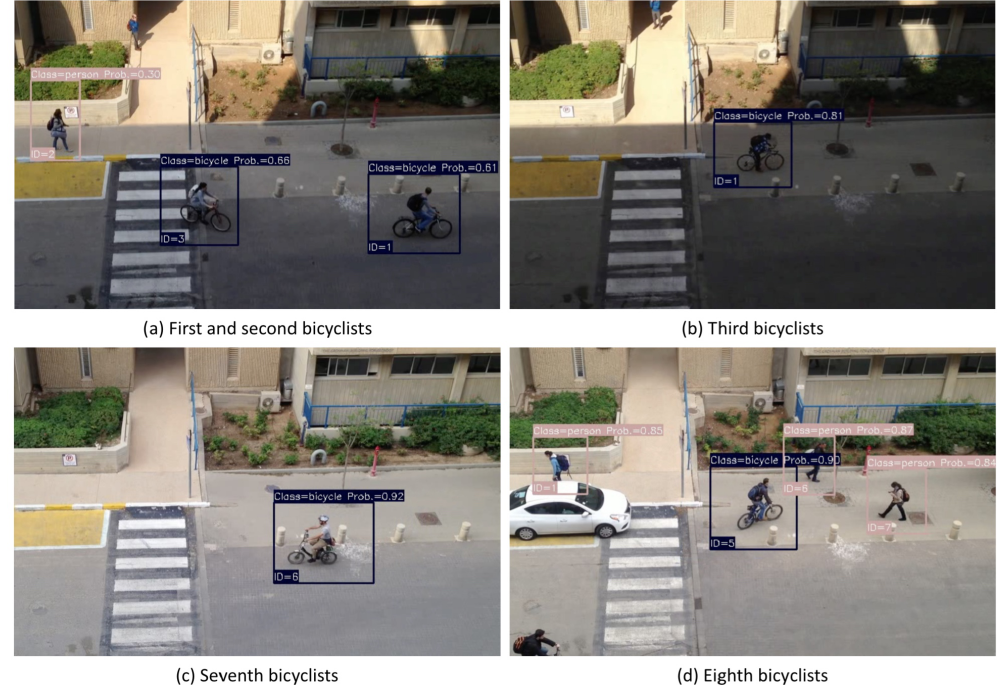
Figure 12. Classification results of the VAP model for bicyclists passing through the test scene. Examining the confidence level of the system for ( a ) the first and second bicyclists, ( b ) the third bicyclist, ( c ) the seventh bicyclist, and ( d ) the eight bicyclist shows gradual increase in the performance of the